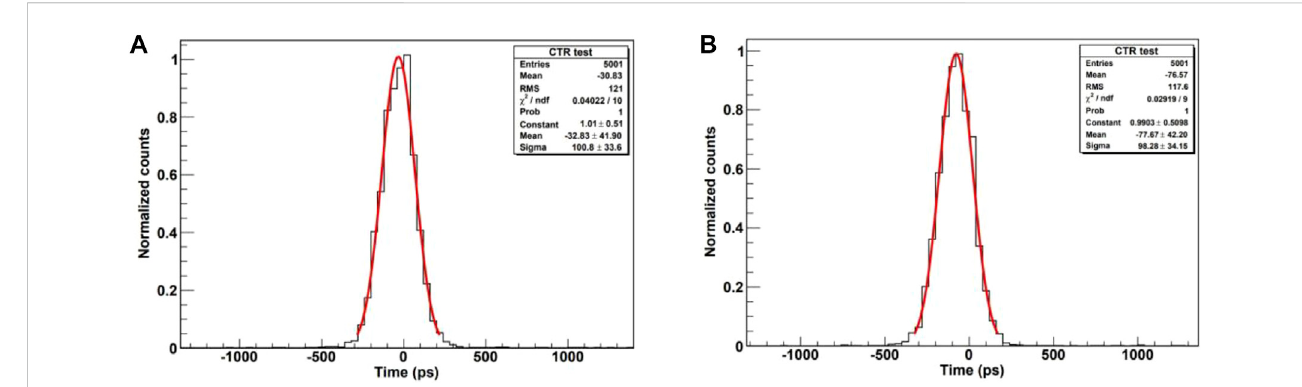
Best CTR spectra based on CEA-based (A) and RF ampli fi er-based (B) readout schemes.